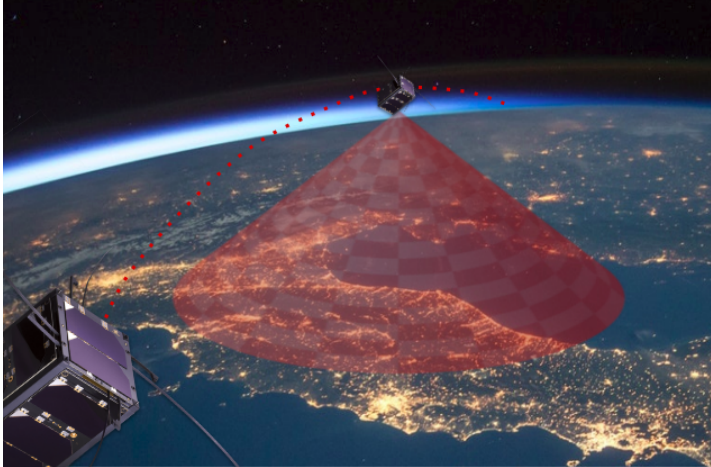
Figure 4. Illustrative scenario in which a CubeSat (or a constellation of them) provides connectivity for internet of things (IoT)